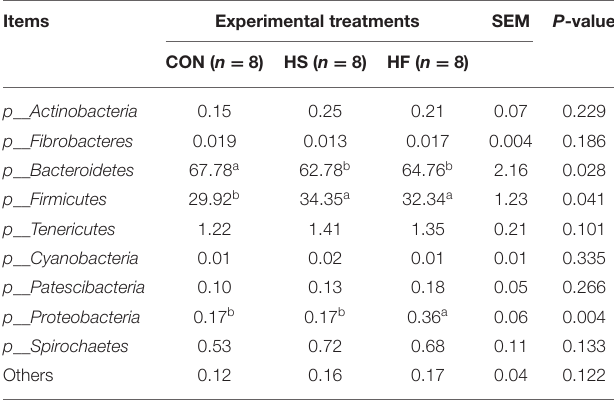
TABLE 6 | Effects of honeycomb flavonoids supplement on relative abundances of ruminal microbiota communities during heat stress conditions (level of phyla, %). Items Experimental treatments